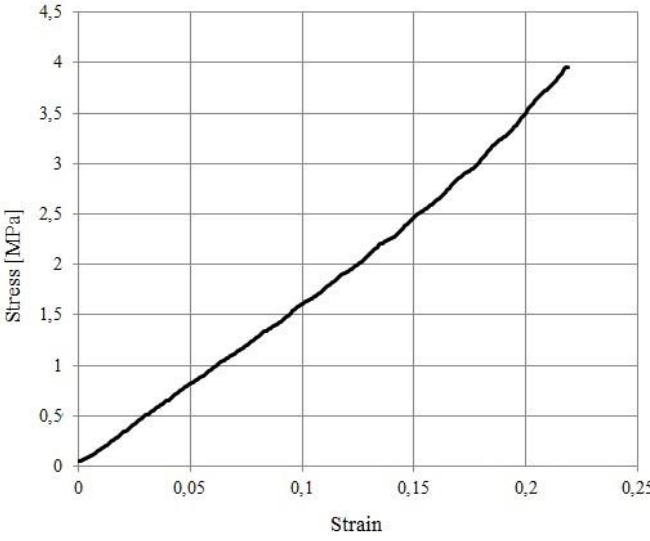
Figure 13. The stress-strain curve for the elastomer sample in a compression test.